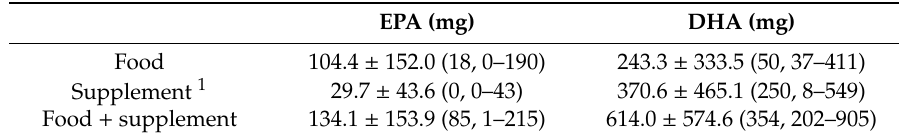
Table 4. Estimated daily intake of EPA and DHA from food, supplement, and food + supplement in lactating women.